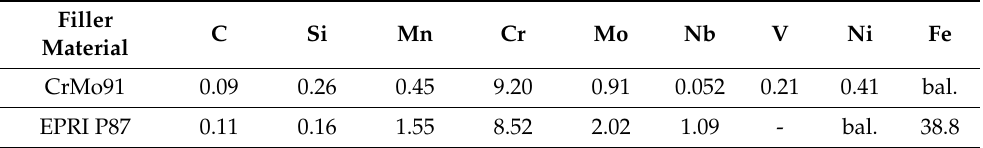
Table 3. Chemical composition of filler materials, %